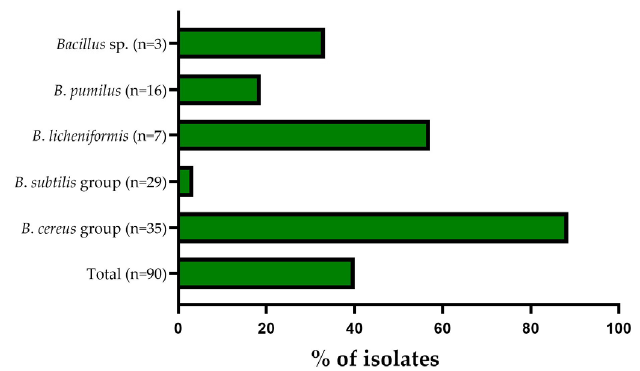
Figure 3. Multidrug-resistance frequency (%) for the studied Bacillus strains ( n = 90) isolated from raw milk. The isolated strains belonged to the following groups: Bacillus sp., B. subtilis group, B. cereus group, or/and represented species B. licheniformis and B. pumilus .